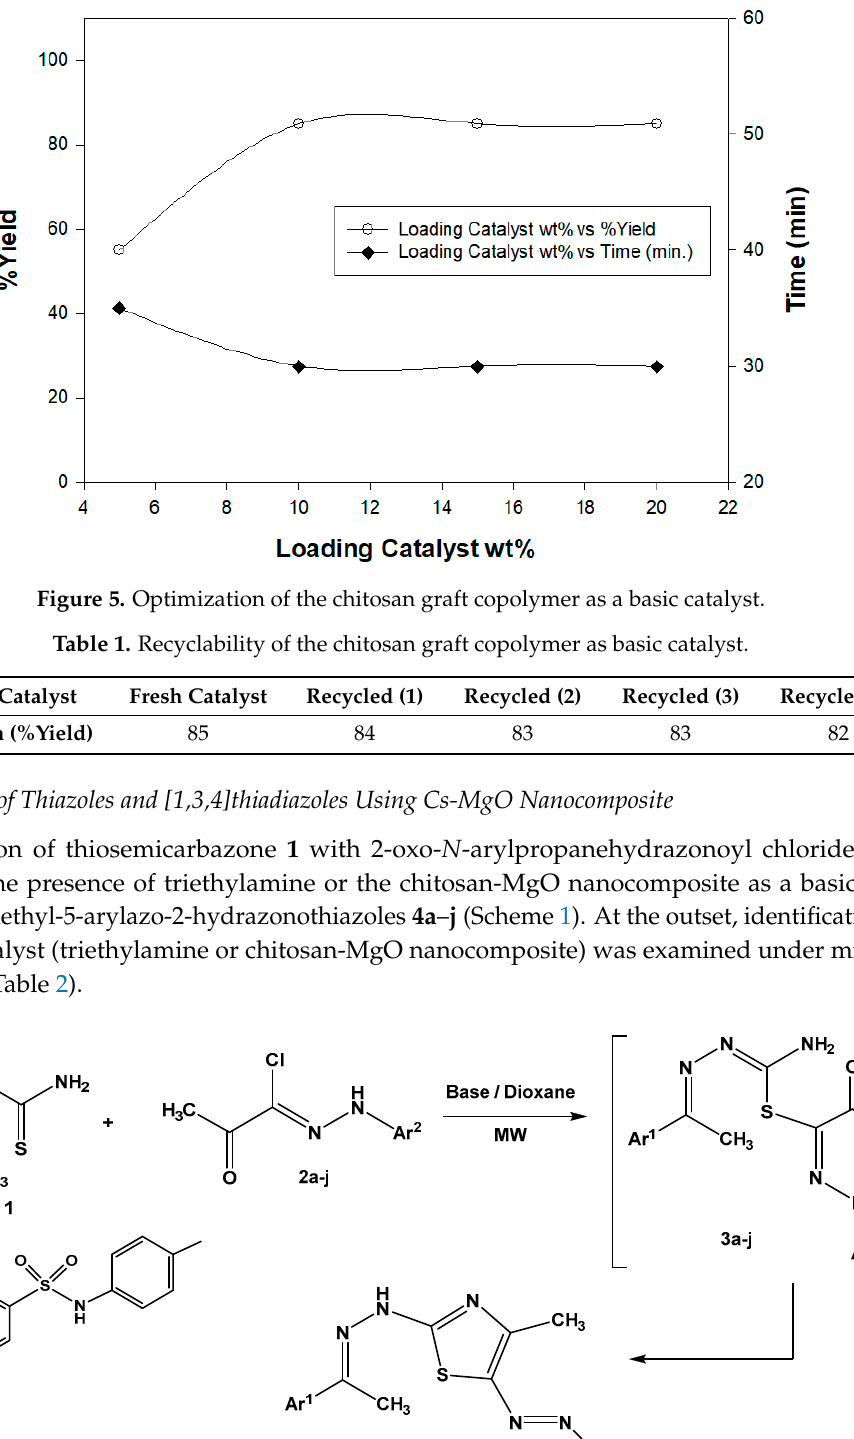
Scheme 1. Synthesis of hydrazonothiazoles 4a – j .